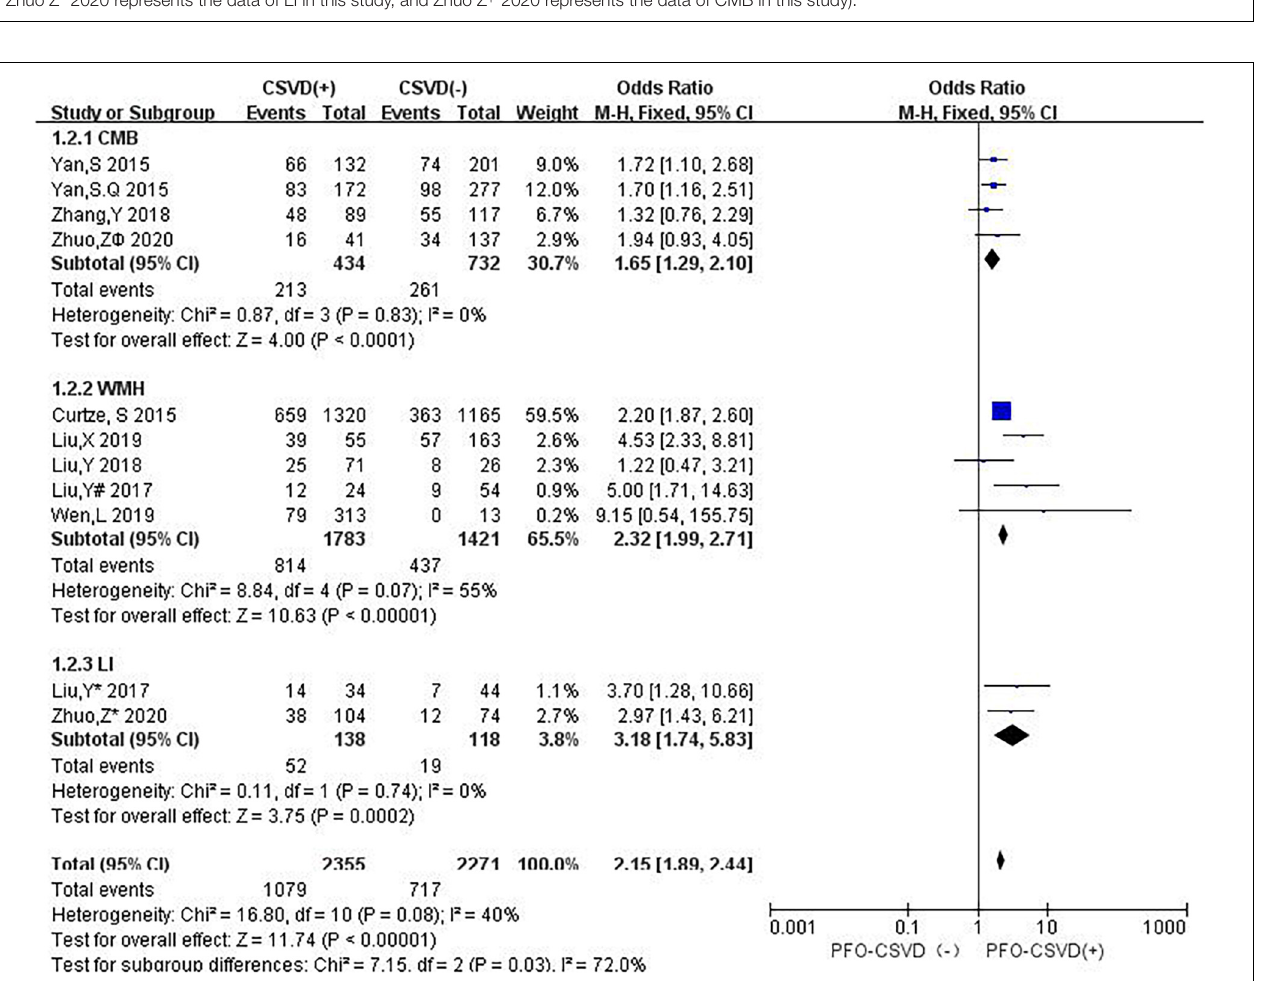
Frontiers in Aging Neuroscience |